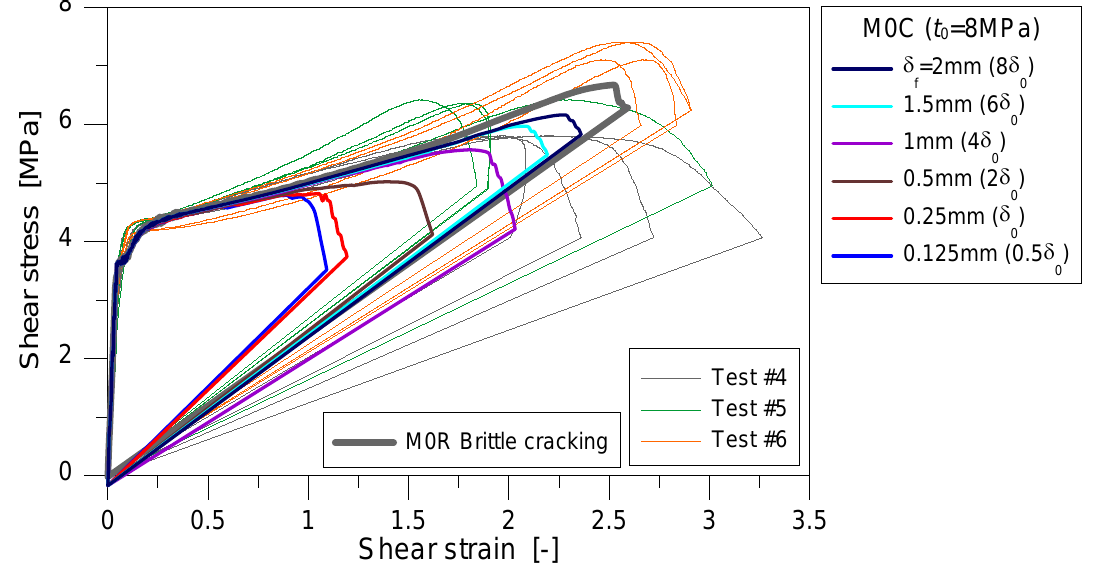
Fig. 5 Comparative numerical assessment of the M0C model (ABAQUS), with respect to earlier studies (Pravdová et al., 2016), as a function of CZM failure separation δ f